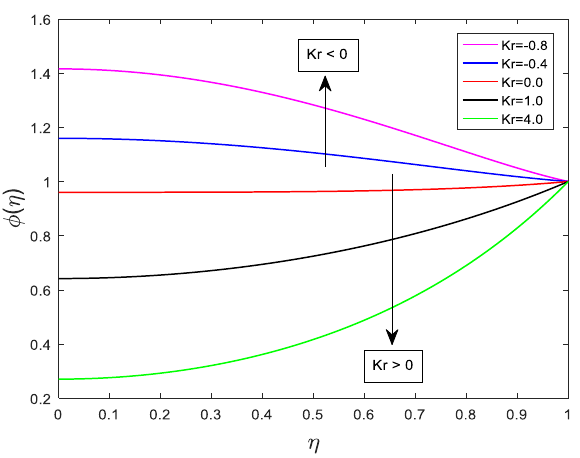
Figure 29: Effect of Kr on ϕ ( η ) for fixed S = Sc = 1.0, N b = 5.0, Ec = β = 0.5, Ha = N